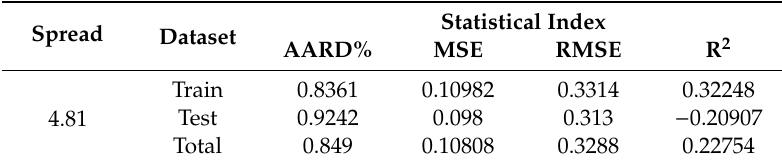
Table 7. Sensitivity analyses on spread parameter for finding best hidden neurons for general regression